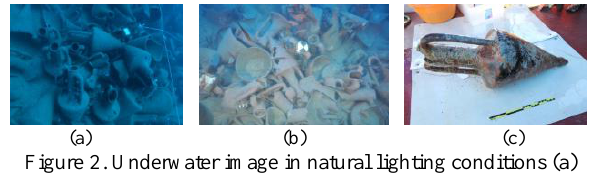
Figure 2. Underwater image in natural lighting conditions (a) and using artificial lighting (b). Image of a recovered